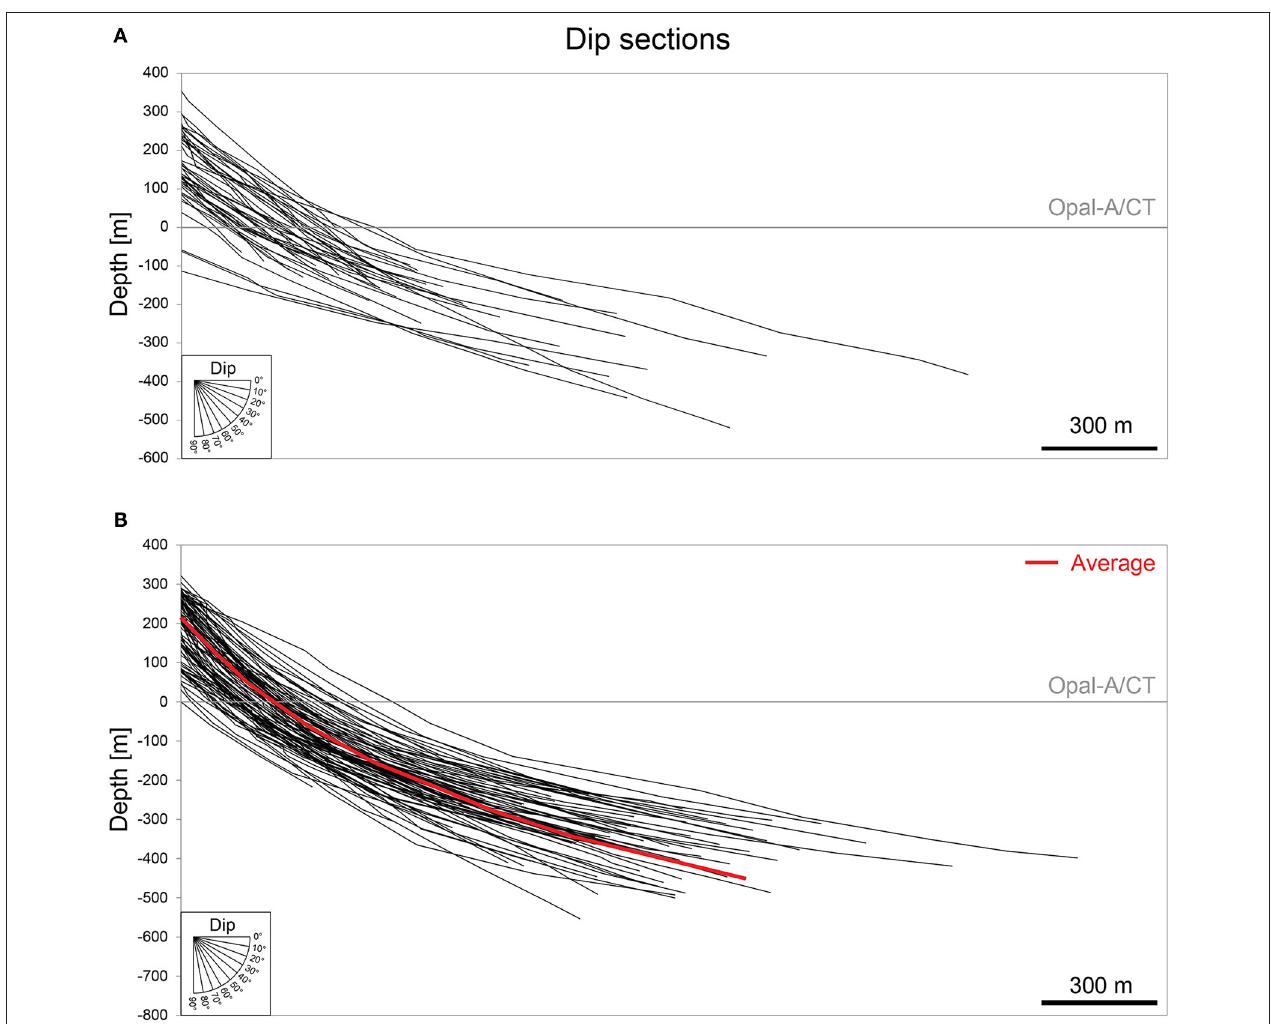
FIGURE 10 | (A) Planar (i.e., constant dip) geometries of faults with c-type displacement-depth profiles and (B) listric (i.e., downward decreasing dip) geometries of faults with b-type displacement-depth profiles in strike-perpendicular